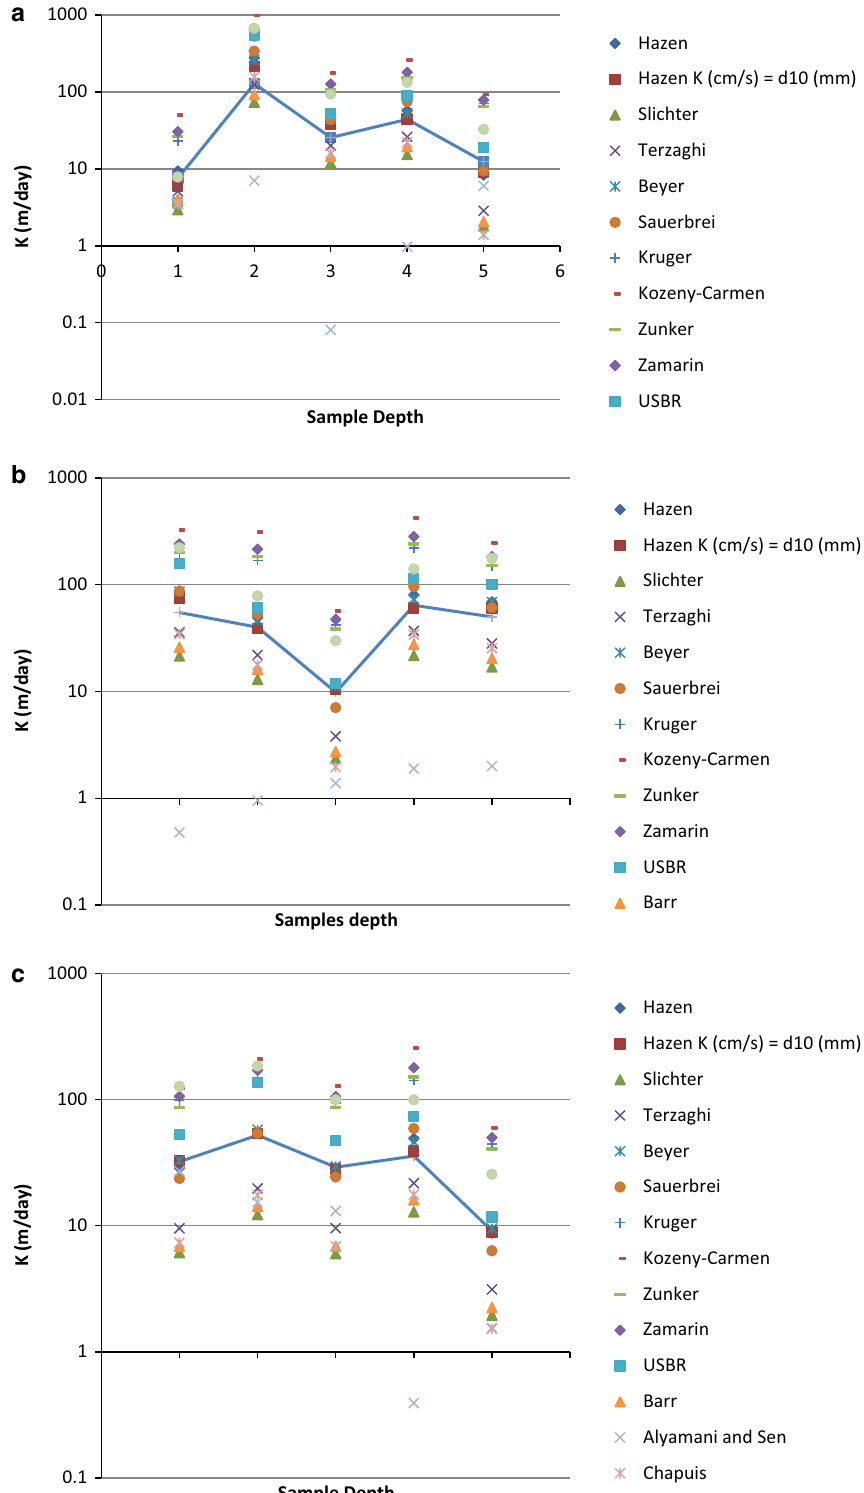
Fig. 5 Estimated hydraulic conductivity using the empiri- cal methods for streambeds (symbols) RVB1 ( a ), RVB2 ( b ) and RVB3 ( c ) with depth and geometric mean (blue